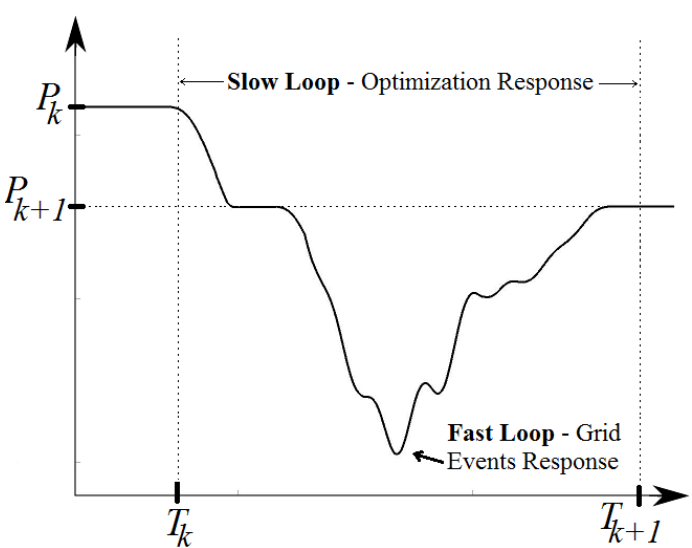
Figure 3. Sample operation and outcome of the slow and fast loop of the front end controller